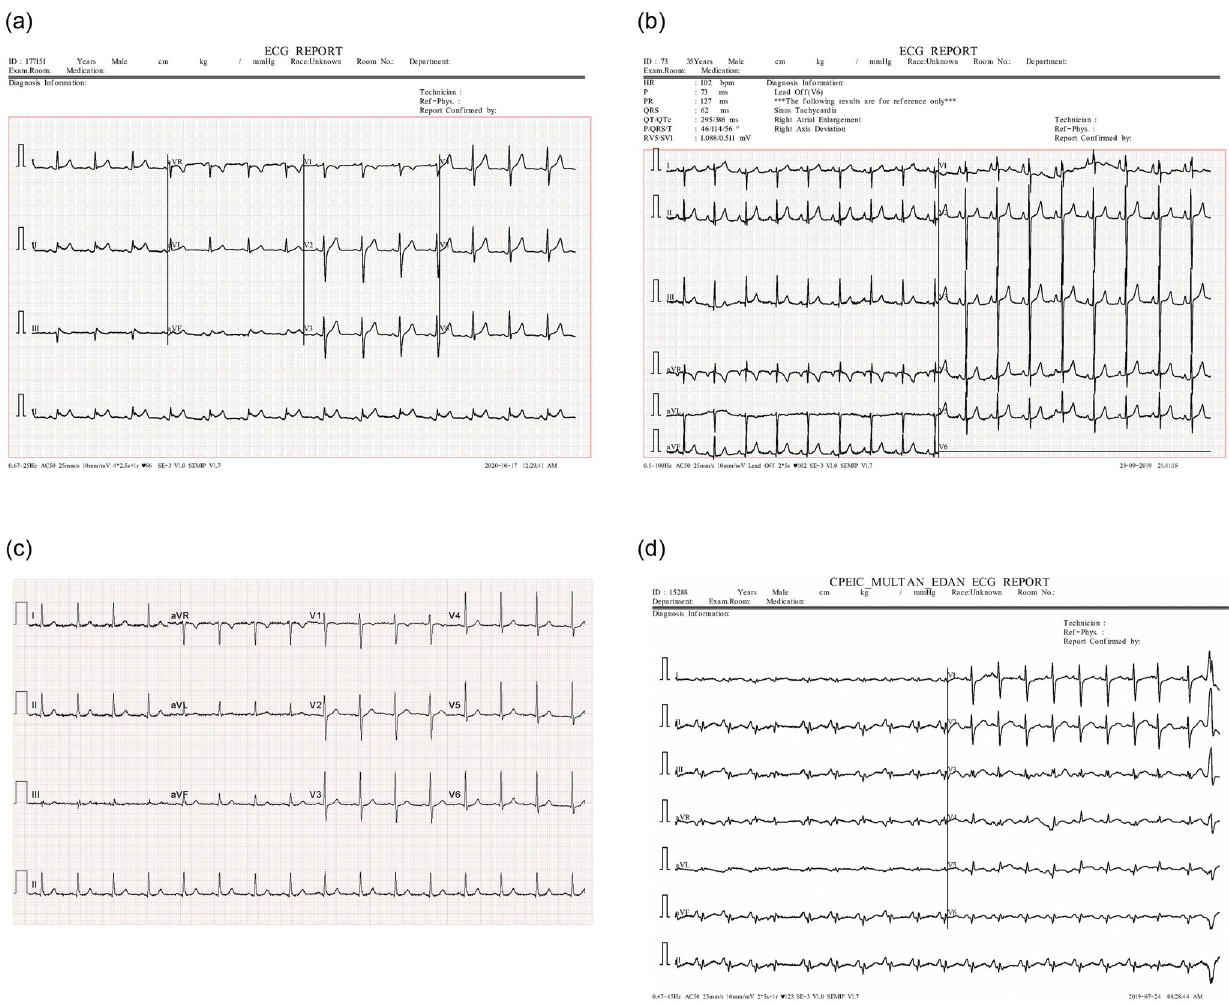
Fig 6. Four types of 12-lead ECG reports in the COVID-19 ECG images dataset.